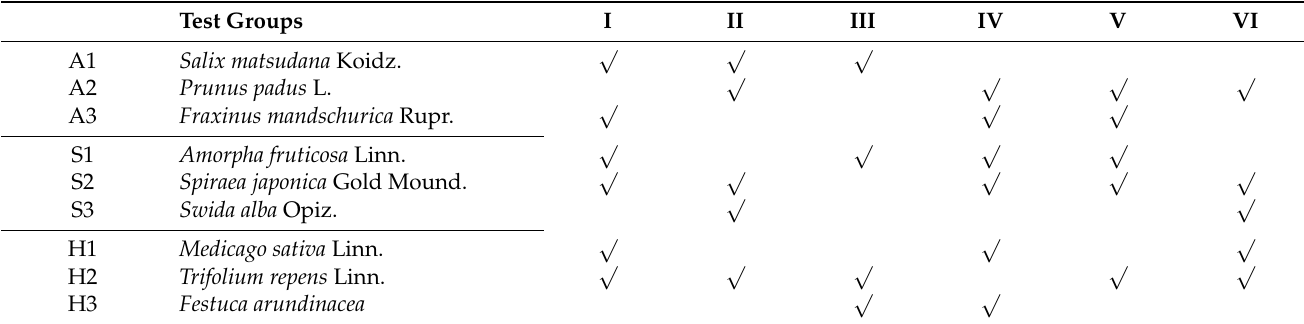
Table 1. Plant materials of the 6 test groups. A checkmark means the plant is included. The series A, S, and H represent arbor, shrub, and herb materials,